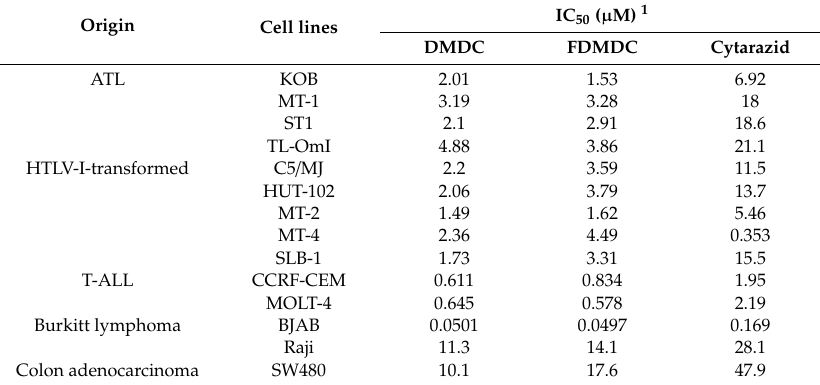
Table 1. Antitumor effects of DMDC, FDMDC, and cytarazid on the growth of various human tumor cell lines in vitro.